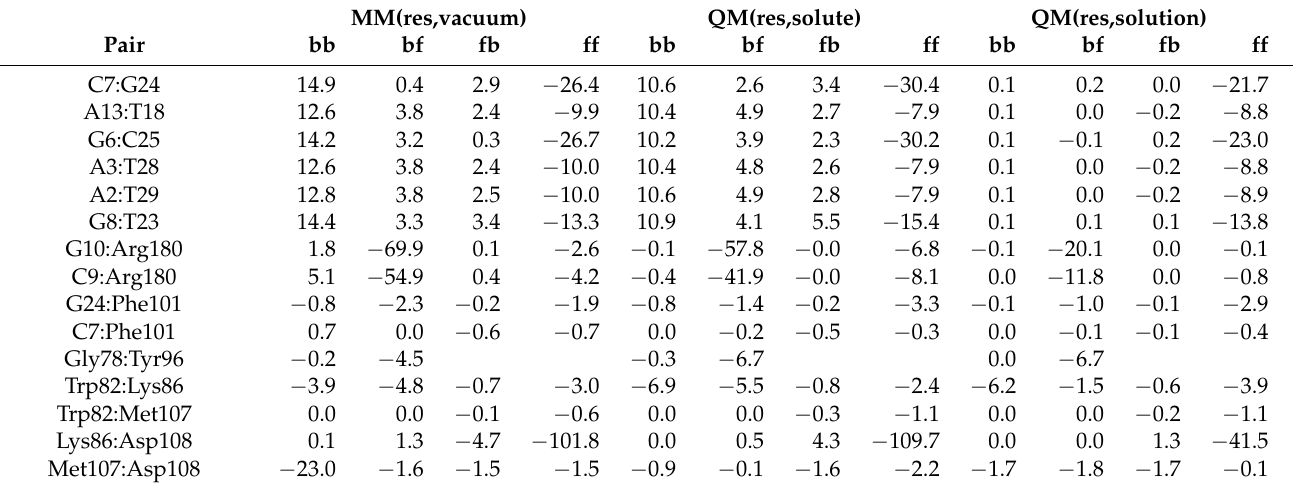
Table 4. Contributions of backbones (b) and functional units (f) to the total interaction energies (kcal mol − 1 ) a , averaged in